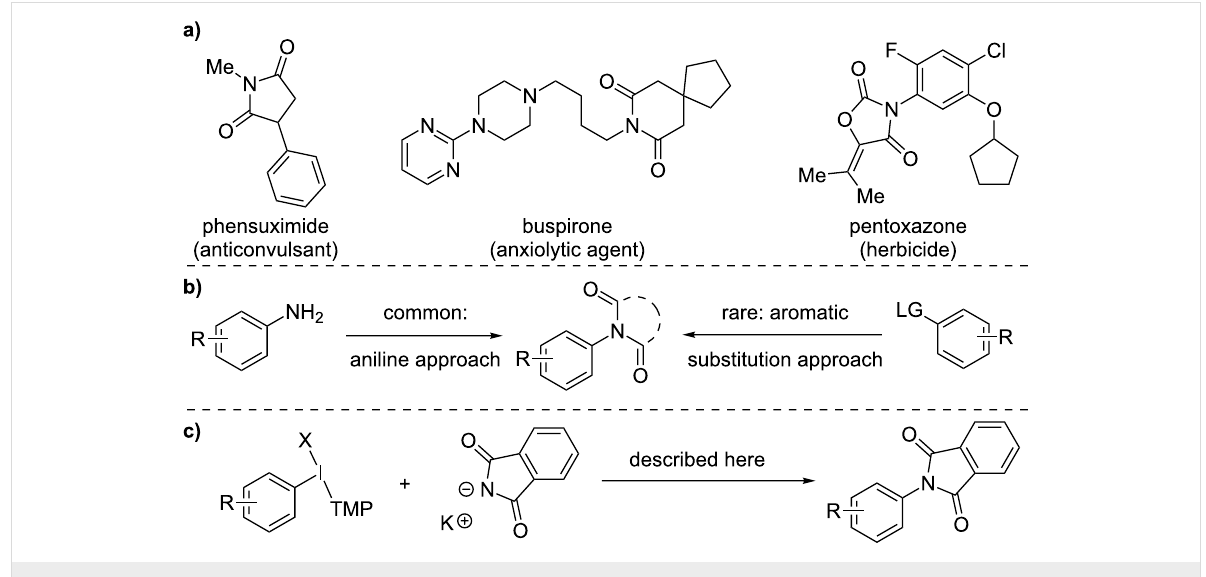
counter anion, solvent and volume, reaction temperature, and stoichiometry (Table 1). Consistent with an electronically con- trolled aryl transfer, the trimethoxyphenyl (TMP) auxiliary was